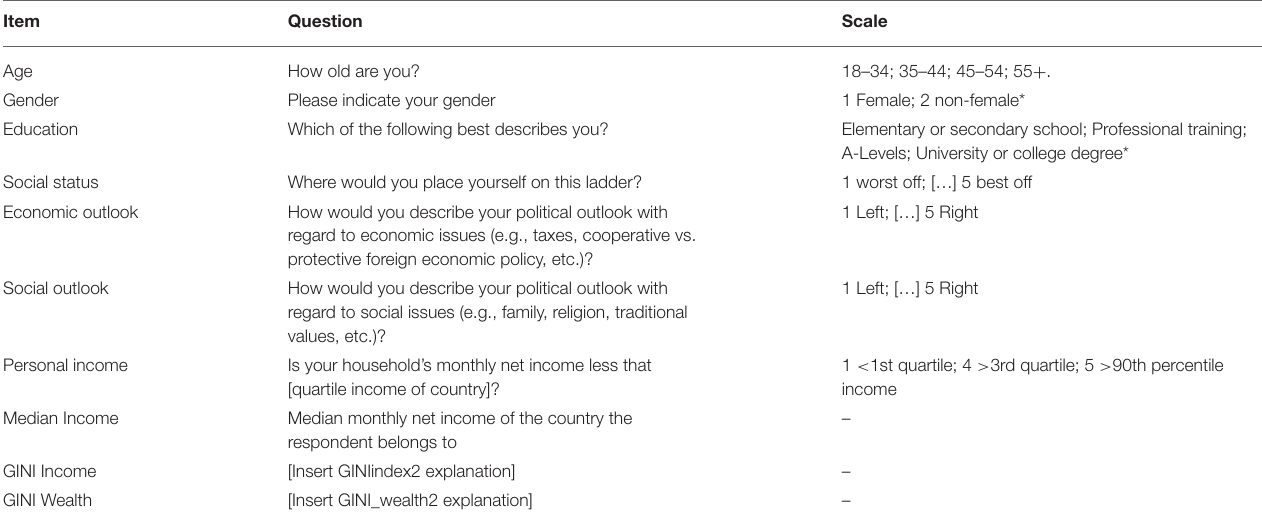
TABLE 4 | Variables included in the regression